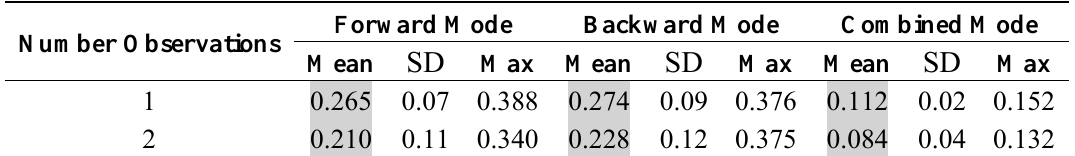
Table 7. Manitoba site. Summary statistics: temporal sequence level mean normalized residuals (mean), standard deviation (SD) and maximum image-level residuals (Max) calculated from all temporal sequences generated with the same number of Landsat observations in Monte Carlo simulations. Residuals are presented for forward, backward and combined mode recursions.